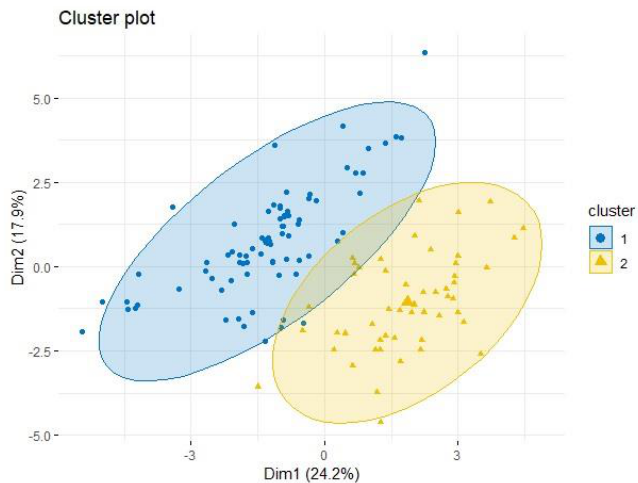
Figure 11. Results of PAM clustering in principal component 1 and 2 cross plot.